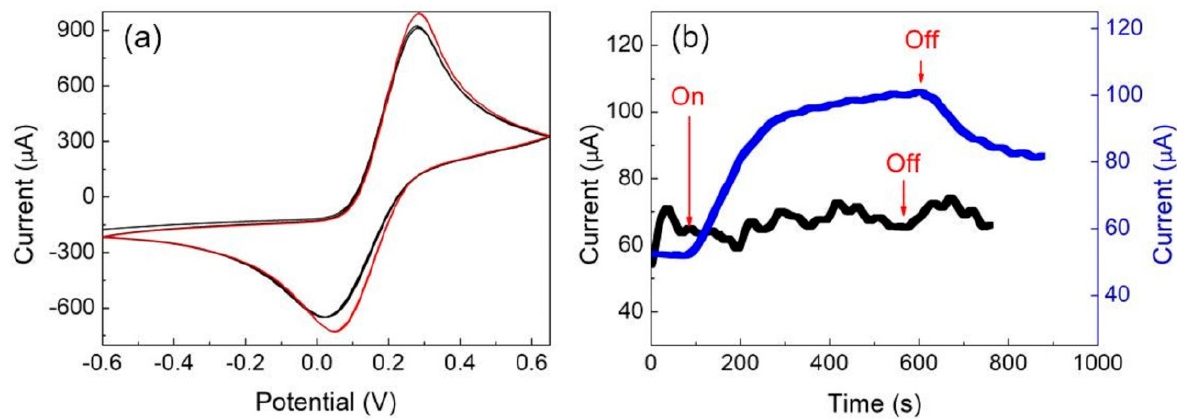
Figure 5. ( a ) Cyclic voltammetry (CV) spectra of Au/ZnPP electrodes without light exposure (black line) and with light exposure (red line). ( b ) Current-time diagram of Au (black lines) and Au/ZnPP electrodes (blue lines) following light treatment.